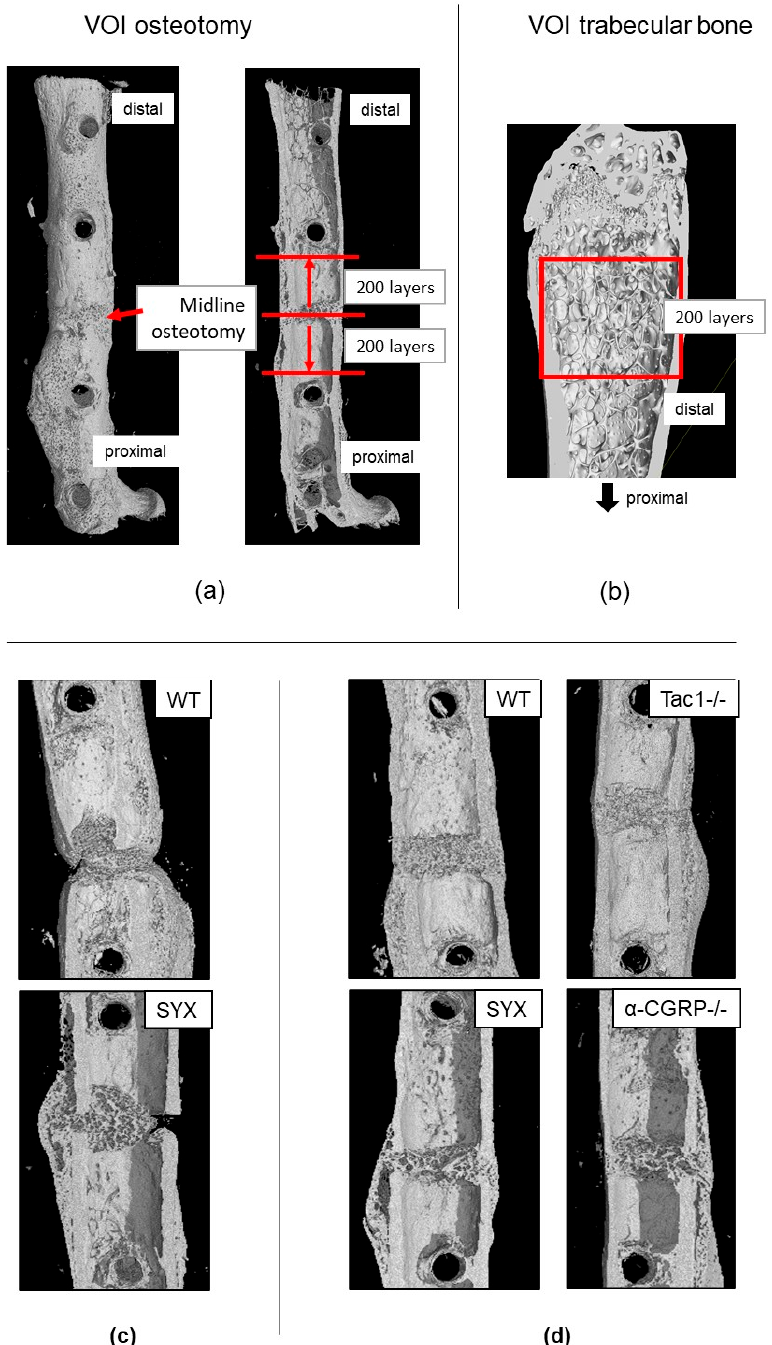
Figure 1. Representative images to demonstrate the region of interest (ROI) settings for µ CT analysis and representative µ CT scans of fractured femora from WT, SYX, Tac1 − / − and α -CGRP − / − mice. ( a ) Volume of interest (VOI) of fractured femora 21 days after fracture. VOI was set 200 layers above and below the midline of the fracture, spanning in total 400 layers. ( b ) VOI of the trabecular bone in the distal part of the contralateral non-fractured femora started 50 layers from the cartilaginous bridge in the growth plate spanning a total of 200 layers. ( c ) Representative fracture site of the fractured femora of WT and SYX mice that collapsed (i.e., breakdown of diaphysis) during preparation for biomechanical analysis. ( d ) Representative fracture site of the fractured femora WT, SYX, Tac1 − / − and α -CGRP − / − mice that underwent biomechanical analysis.